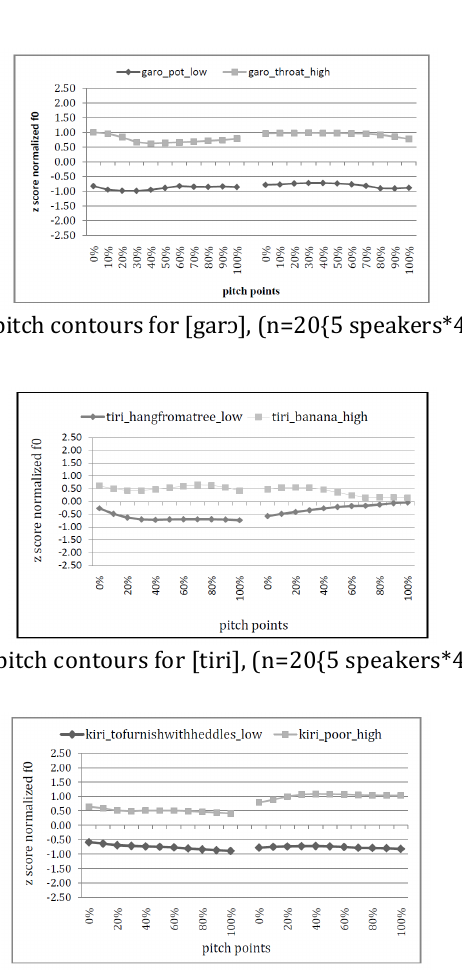
Figure 15: Normalized pitch contours for [kiri], (n=20{5 speakers*4 iterations each})